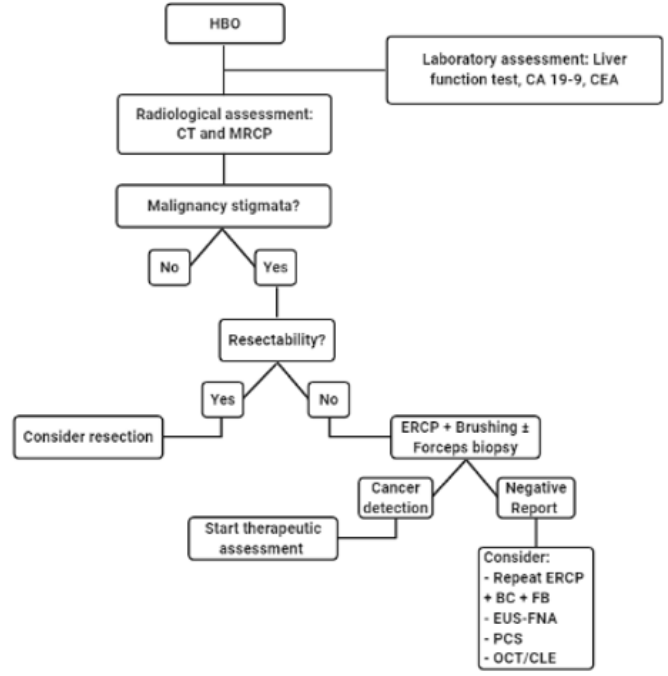
Figure 10. Diagnostic algorithm (HBO: hilar biliary obstruction; Ca 19-9: carbohydrate antigen 19-9; CEA: carcinoembryonic antigen; CT: computed tomography; MRCP: magnetic resonance cholangiopancreatography; ERCP: endoscopic retrograde cholangiopancreatography; BC: biliary brushing; FB: endoscopic forceps biopsy; EUS-FNA: echoendoscopic fine-needle aspiration; PCS: peroral cholangioscopy; OCT: optical coherence tomography; CLE: confocal laser endomicroscopy).